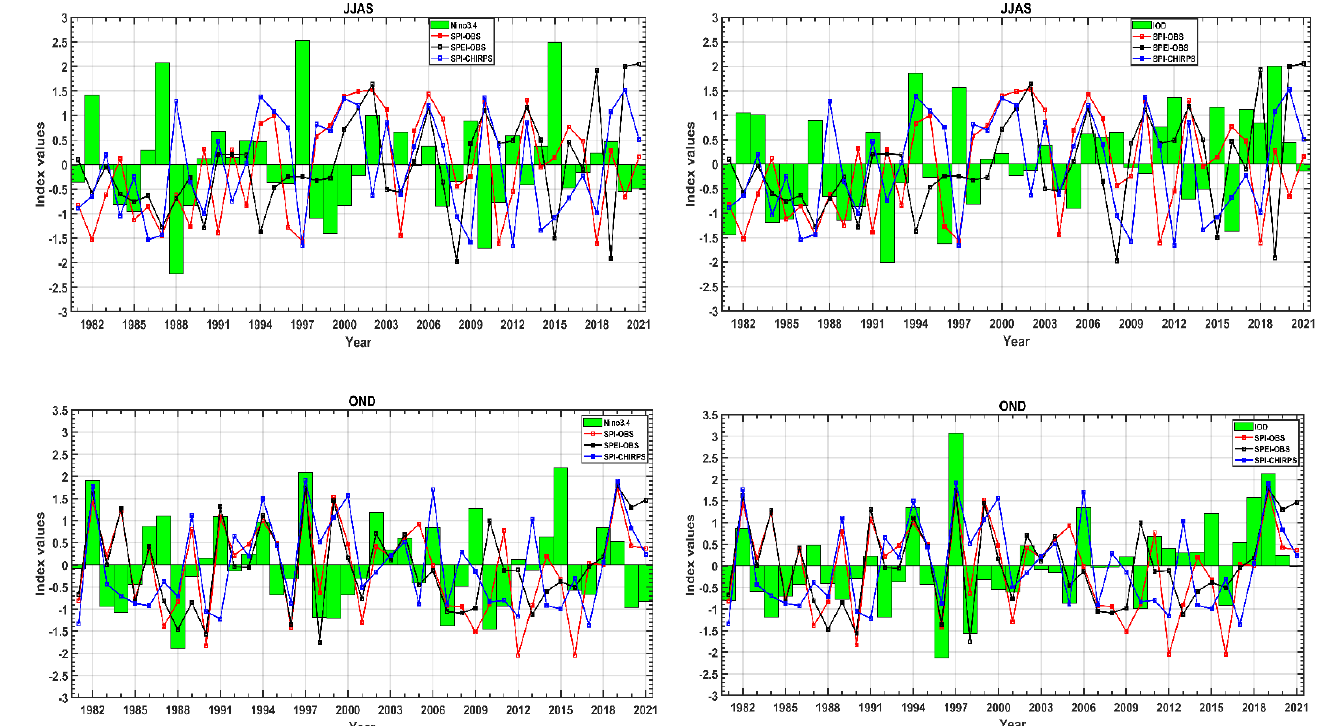
Figure 11. Time series of seasonal variability (JJAS and OND) of SPI and SPEI observations and